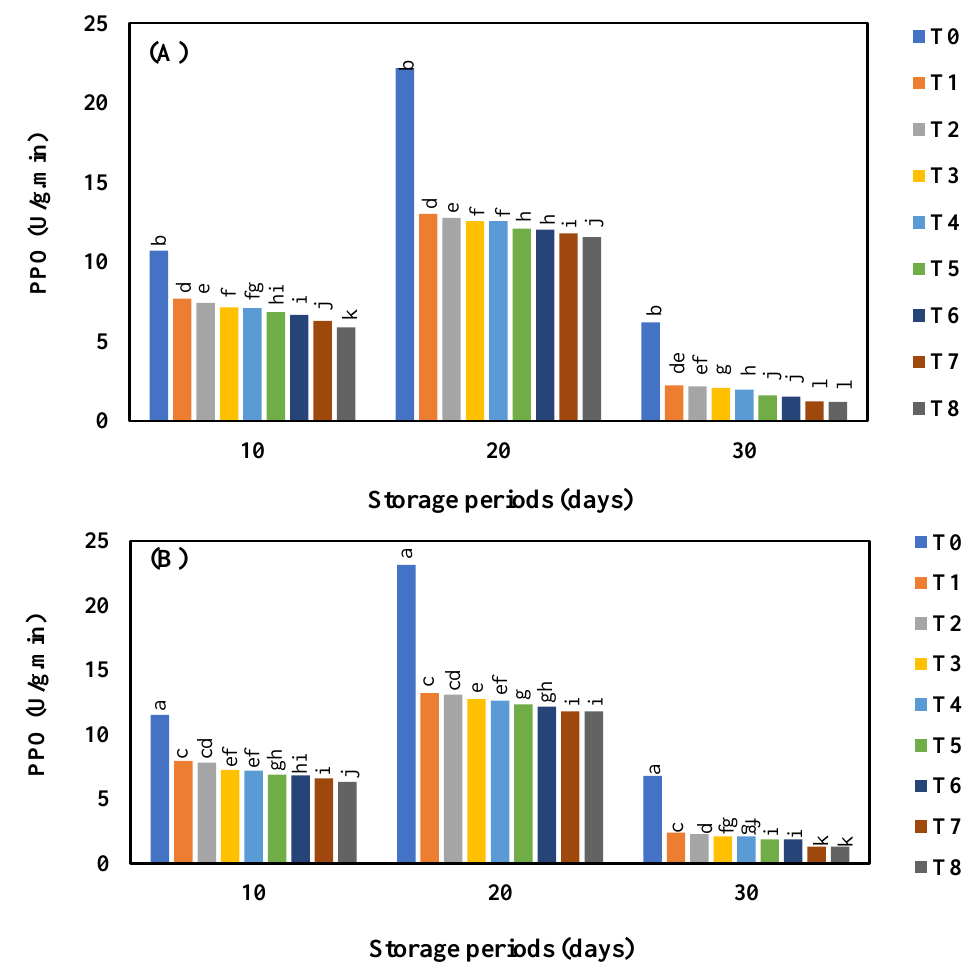
Figure 6. Effect of AgNO 3 and Ag-NPs on Polyphenol Oxidase (PPO) in Shine Muscat ( A ) Kyoho ( B ) of grape varieties during 30 days cold storage.